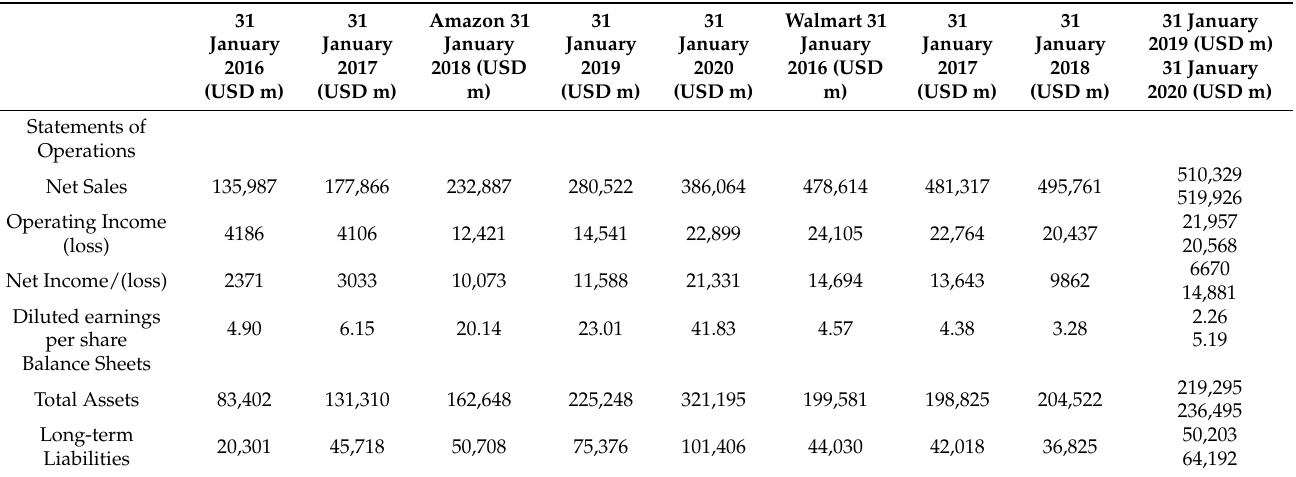
Table 5. Comparative data between Amazon and Walmart’s financial performance and position statements